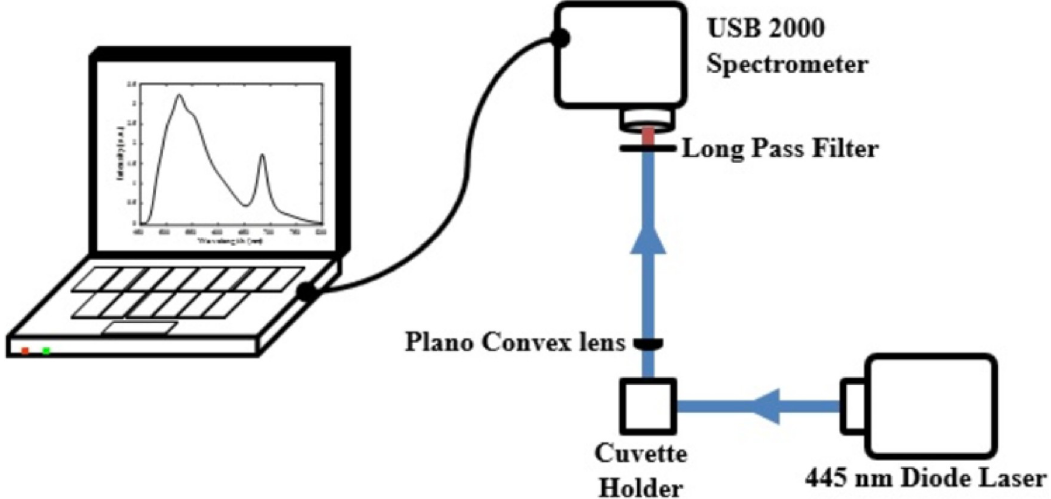
Fig 2. Experimental setup used to measure the LIF spectra of water samples from the mosquito breeding sites.